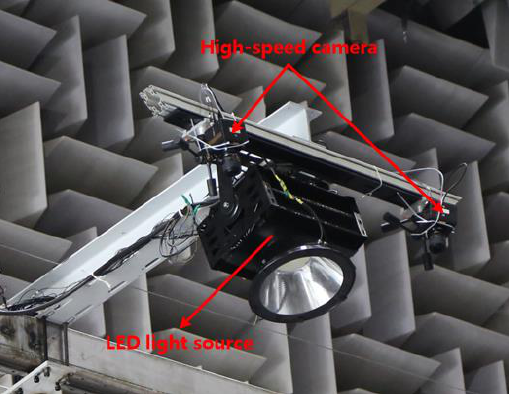
Figure 3. Installed photogrammetric system in the experiments.